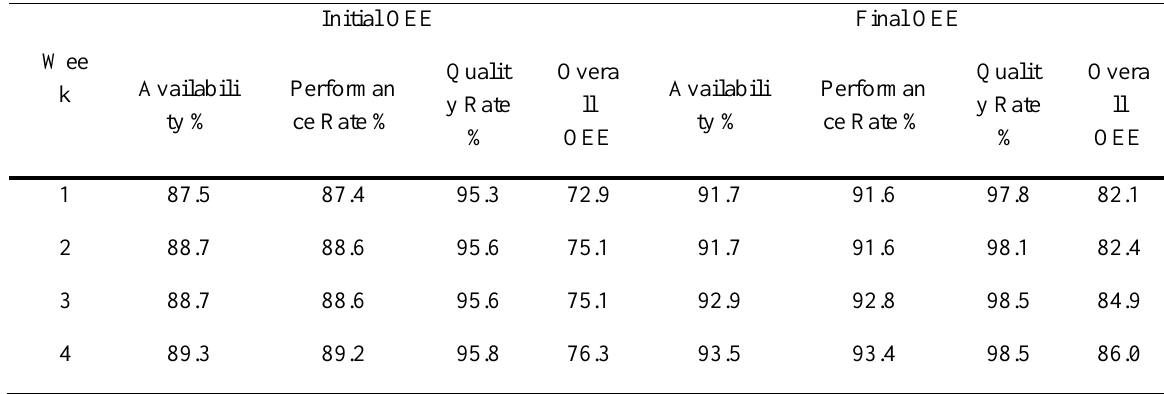
Table 10. Comparison between Initial OEE and Final